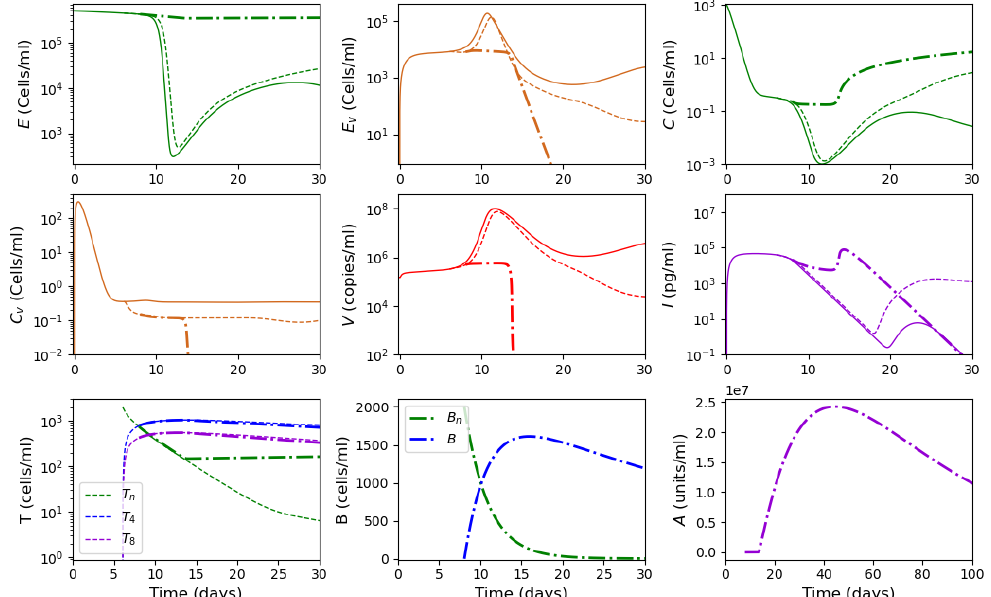
Figure 6. Numerical simulation of innate and adaptive immune response in system (10)–(21). The color code corresponds to Figure A2. Figures in the first two rows for the variables E , E v , C , C v , V and I show the action of the innate immune response only (solid lines), innate immune response with CTLs beginning from day 6 (dashed lines) and with antibodies from day 8 (dash-dot lines). The figures of the last row show the T cells, B cells and antibodies. The initial conditions and parameter values are specified in Tables A1–A3. Other values: initial viral load = 1.495 · 10 5 , k 5 =